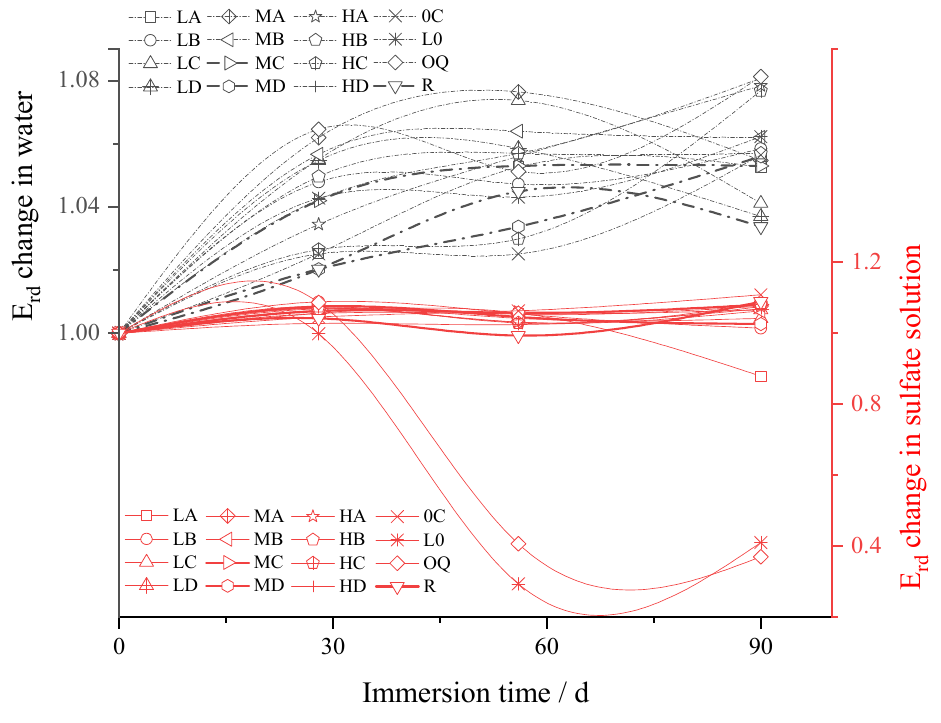
Figure 13. Change of relative dynamic elastic modulus. As can be seen from Figure 13, the relative dynamic elastic modulus of each test group immersed in water has increased in 90 days but exhibits different trends. The relative dynamic elastic modulus of group OQ increases at 28 days, decreases at 56 days, and increases again at 90 days; the relative dynamic elastic modulus of group 0C